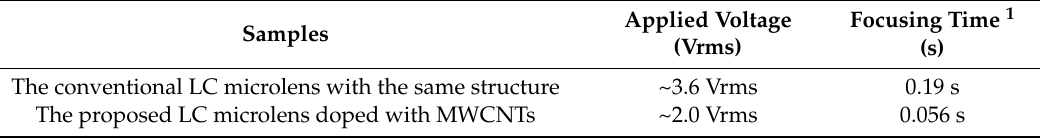
Table 1. Comparison results among two types LC microlens.